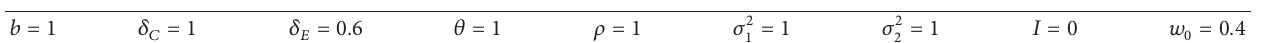
Table 2: The values of other